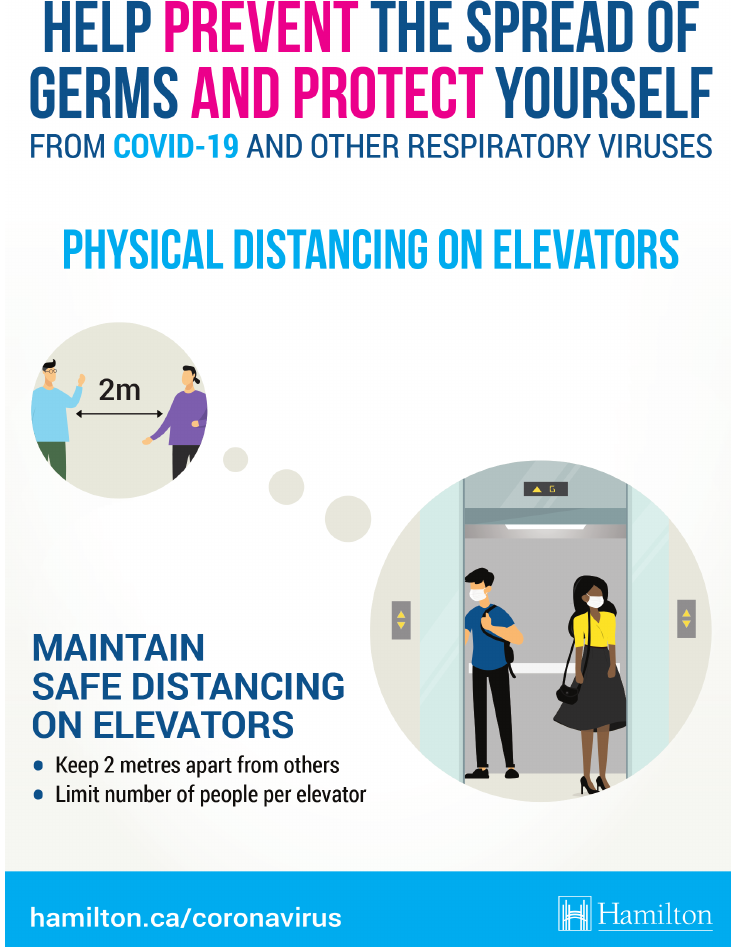
Figure 1. City of Hamilton public health recommendations poster. Source: City of Hamilton (2021). recommended by public health officials. Quebec’s